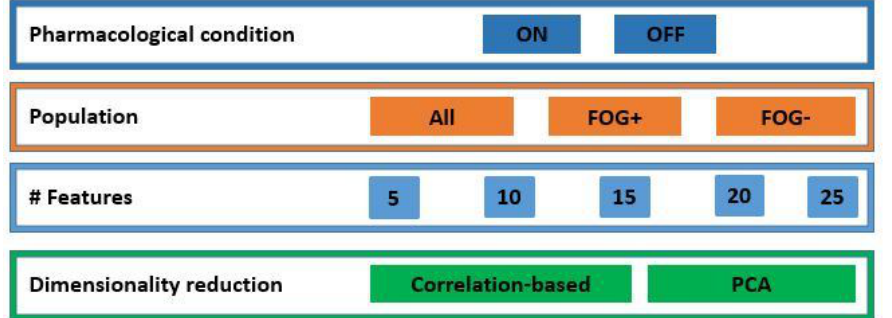
Figure 5. Schematic of the analysis performed. The processing was performed for both pharmacolog- ical conditions, different populations, different sizes of the feature set, and different dimensionality reduction methods. ON: under dopaminergic therapy; OFF: not under dopaminergic therapy; FOG: patients with Parkinson’s disease and freezing of gait; FOG − : patients with Parkinson’s disease without freezing of gait; PCA: principal component